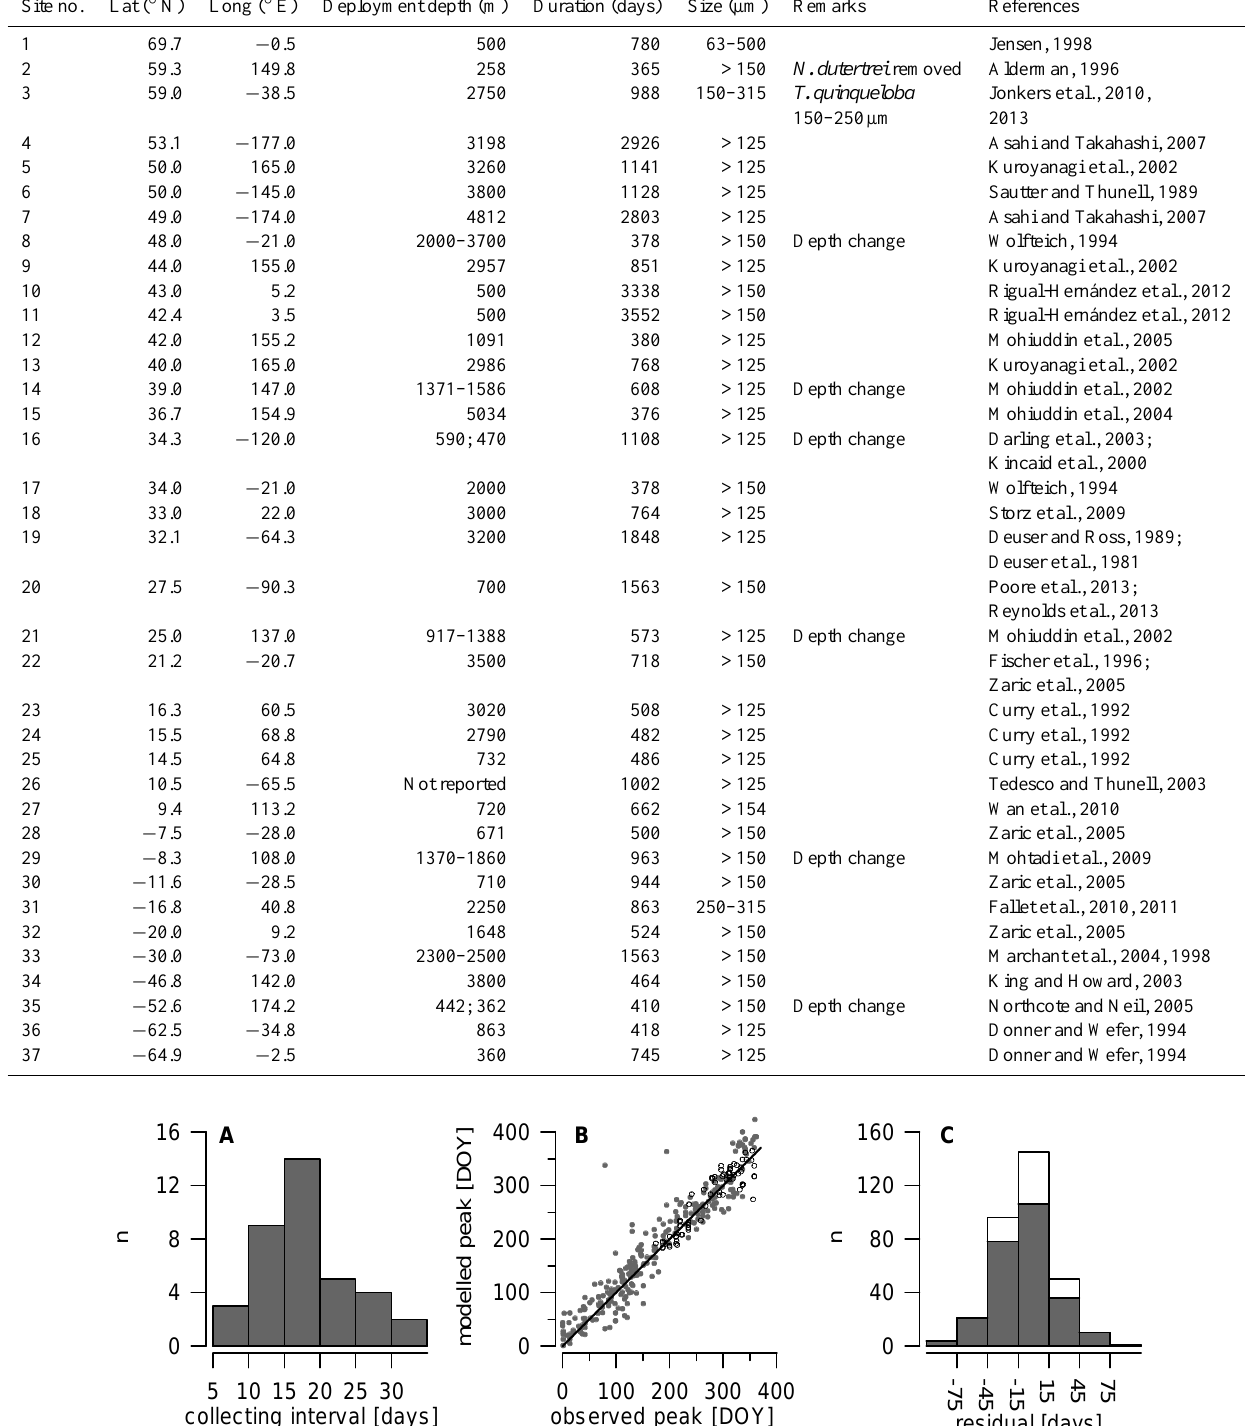
Table 1. Details of shell flux time series used in this study. Site numbers refer to Fig. 1. Site no.